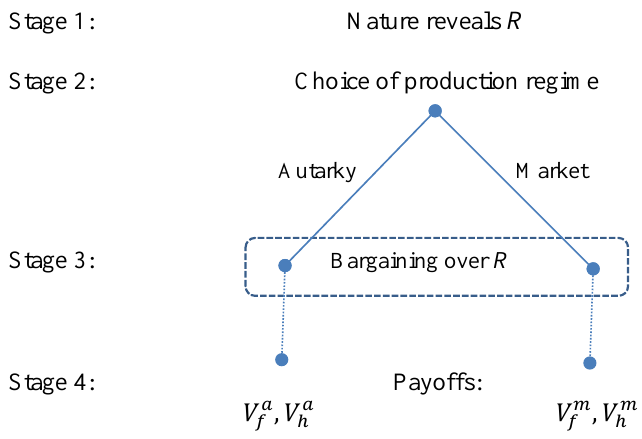
Figure 1: The market integration